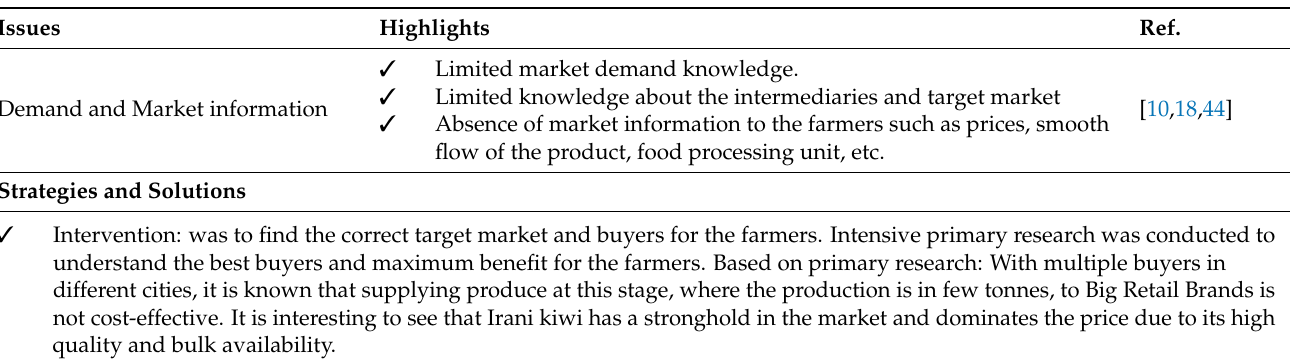
Table 8. Compiled market issues in the value chain of kiwi in Bageshwar District and strategies and solutions